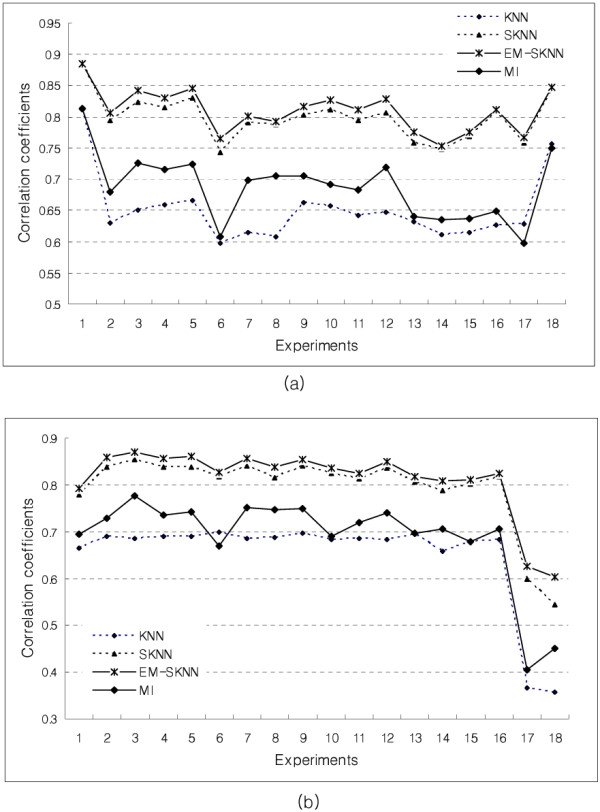
Comparison of the performance of KNN, SKNN, EM-SKNN, and MI methods by the correlation coefficients for each column between the original data and the imputed data of time-series data. The imputed data set was created by each imputation method from the data set having 50% of randomly (a) or non-randomly (b) generated missing entries.